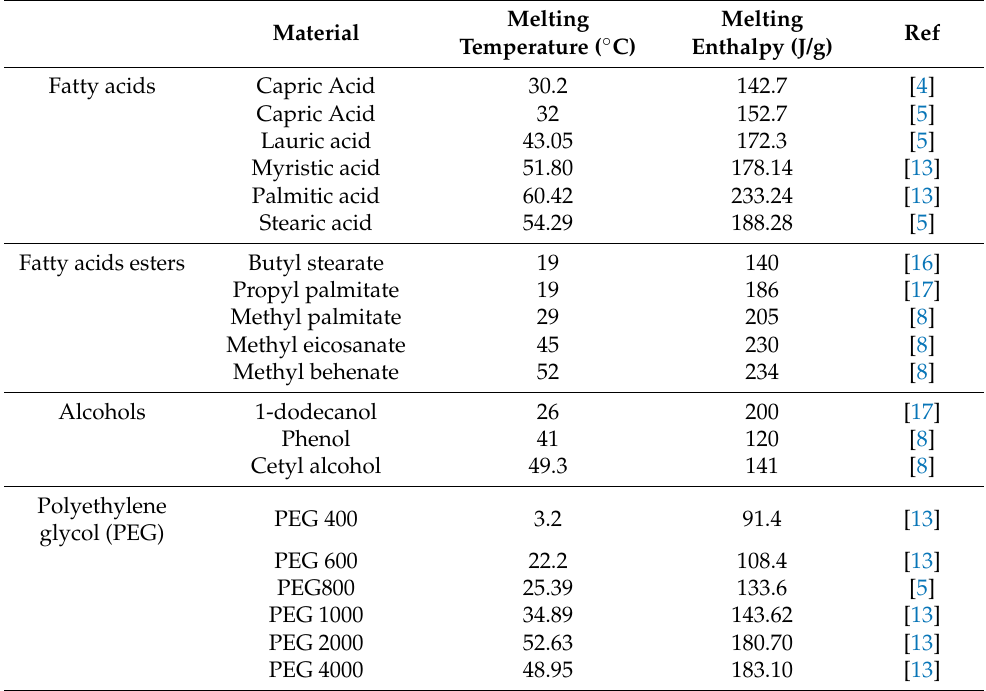
Table 2. Thermal properties of